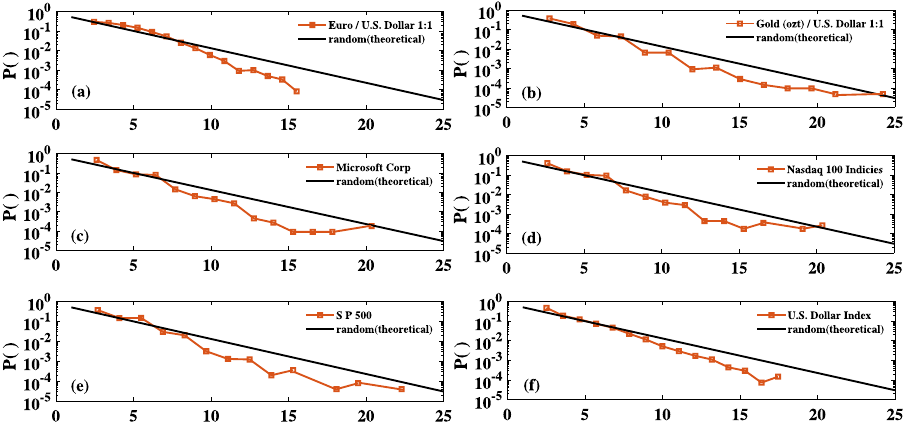
Figure 10. Semi-logarithmic presentation of PDFs of the degree of nodes for: any random process (solid black line) which follows Eq. (5), the exchange rate for euros to dollars (Euro/U.S. Dollar 1:1) from 04 January 1971 till 23 July 2021, gold price per ozt (Gold (ozt)/U.S. Dollar 1:1) from 01 March 1793 till 23 July 2021, Microsoft corp stock price from 13 March 1986 till 23 July 2021, NASDAQ 100 index from 1 October 1985 till 23 July 2021, S& P 500 index from 2 January 1952 till 23 July 2021, U.S. dollar index from 4 January 1971 till 23 July 2021.